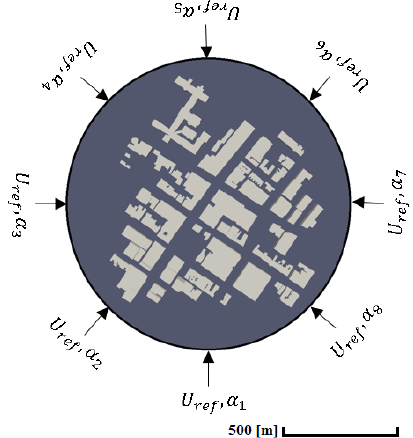
Figure 1. Setup of CityFFD boundary conditions for different wind directions.